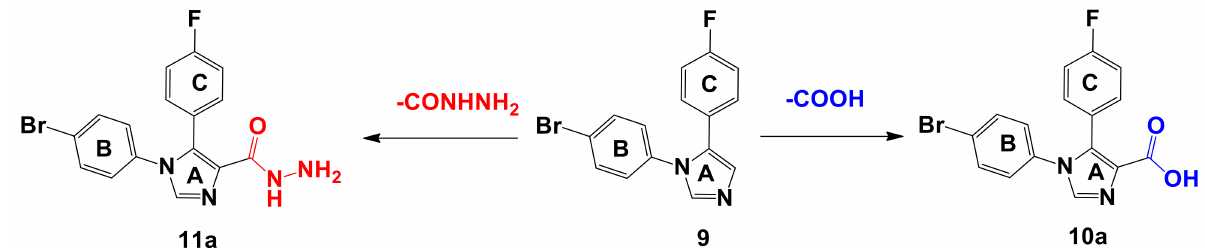
Figure 2. Modification of hit compound 9 by including a carboxylic acid ( 10a ) or carbohydrazide group ( 11a